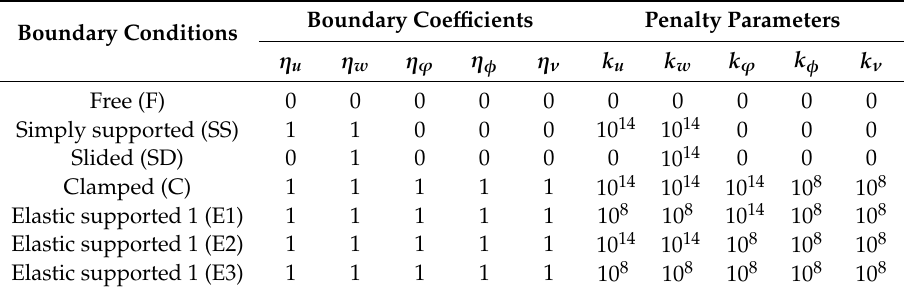
Table 1. Boundary coe ffi cients and penalty parameters for various boundary